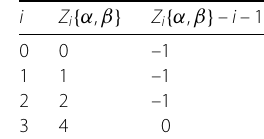
Table 1 Calculation of index s in the